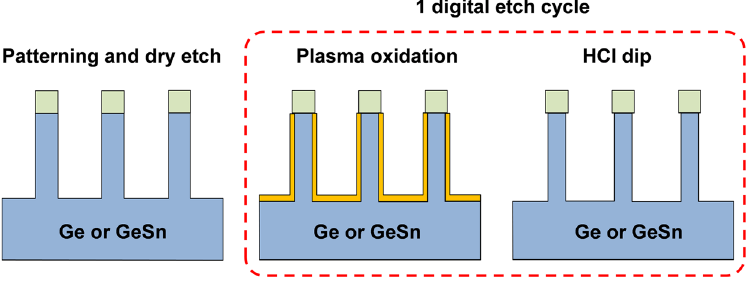
Figure 1. Illustration of the process flow for fabrication of extremely scaled Ge or Ge 1 − x Sn x